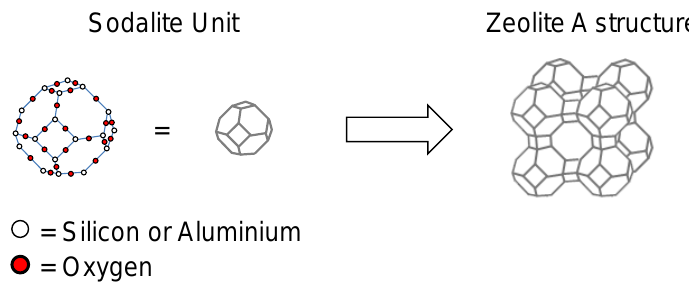
Figure 3. Schematic of a typical zeolite structure made up of sodalite units.